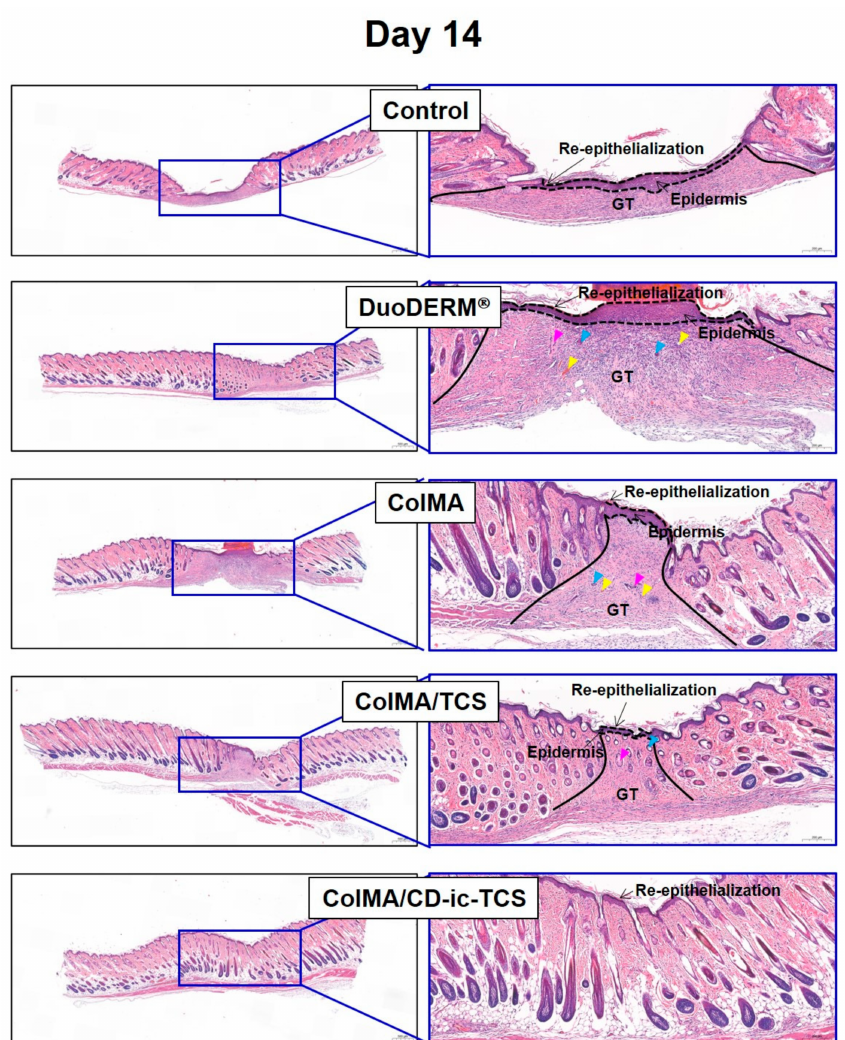
Figure 9. H&E-stained slides of wound defects treated with DuoDERM ® , ColMA, ColMA/TCS, or ColMA/CD-ic-TCS for 1, 7, and 14 days. The ( left ) and ( right ) images were observed at 2.0 × (500 µ m) and 7.0 × (200 µ m), respectively. ColMA/TCS—triclosan (TCS) incorporated ColMA; ColMA/CD-ic- TCS—HP- β -CD/TCS complex incorporated ColMA; GT—granulation tissue. Spaces in black and dotted lines indicate the epidermis and GT,